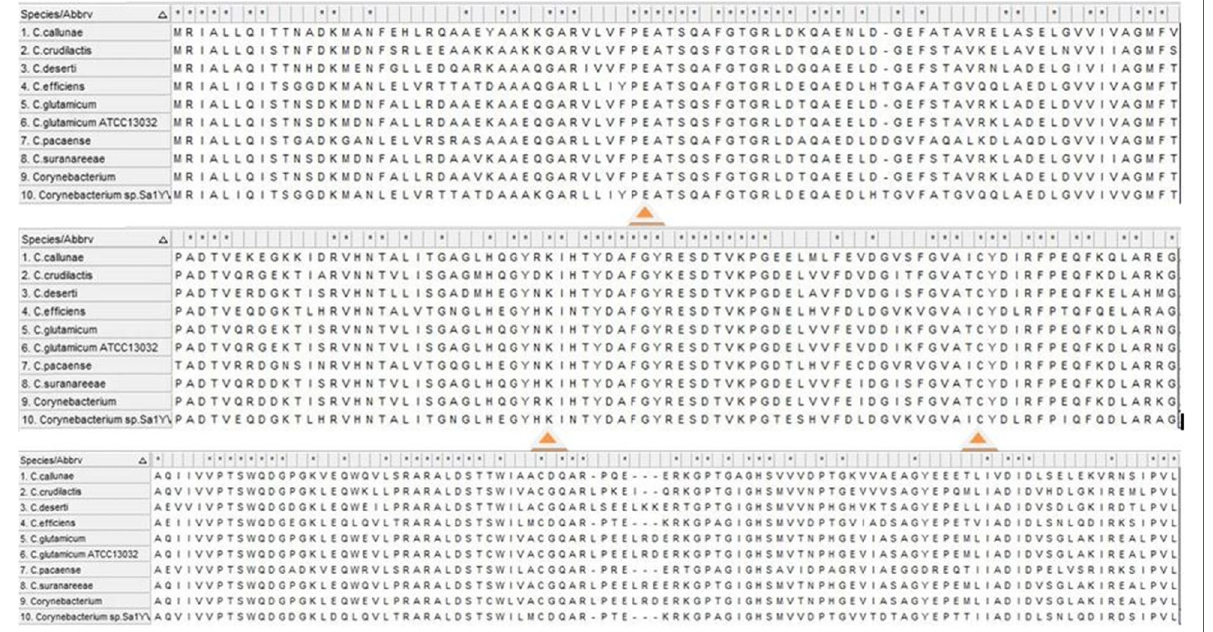
Fig. 1 Multiple sequence alignment of nitrilase sequence of Corynebacterium sp. Catalytic triad residues (40E, 115K, and 151C) are highlighted in yellow